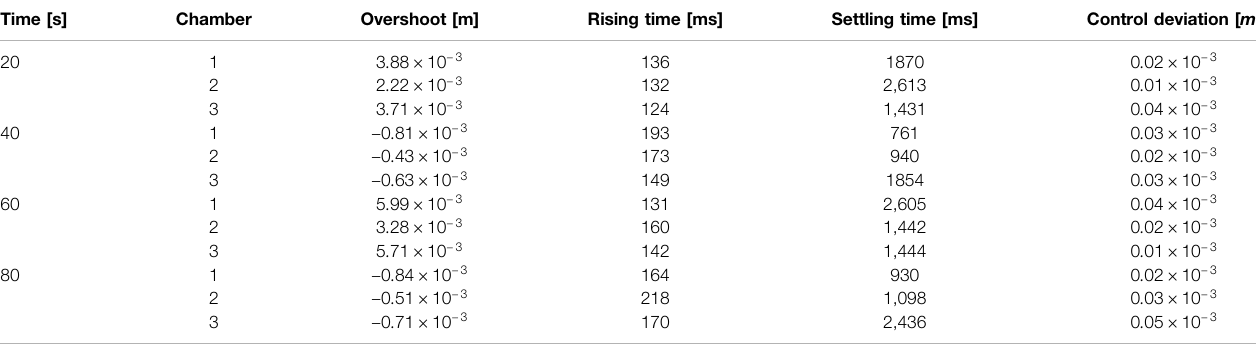
TABLE 3 | Performance of the PID controller for closed-loop control of the chambers ’ lengths.